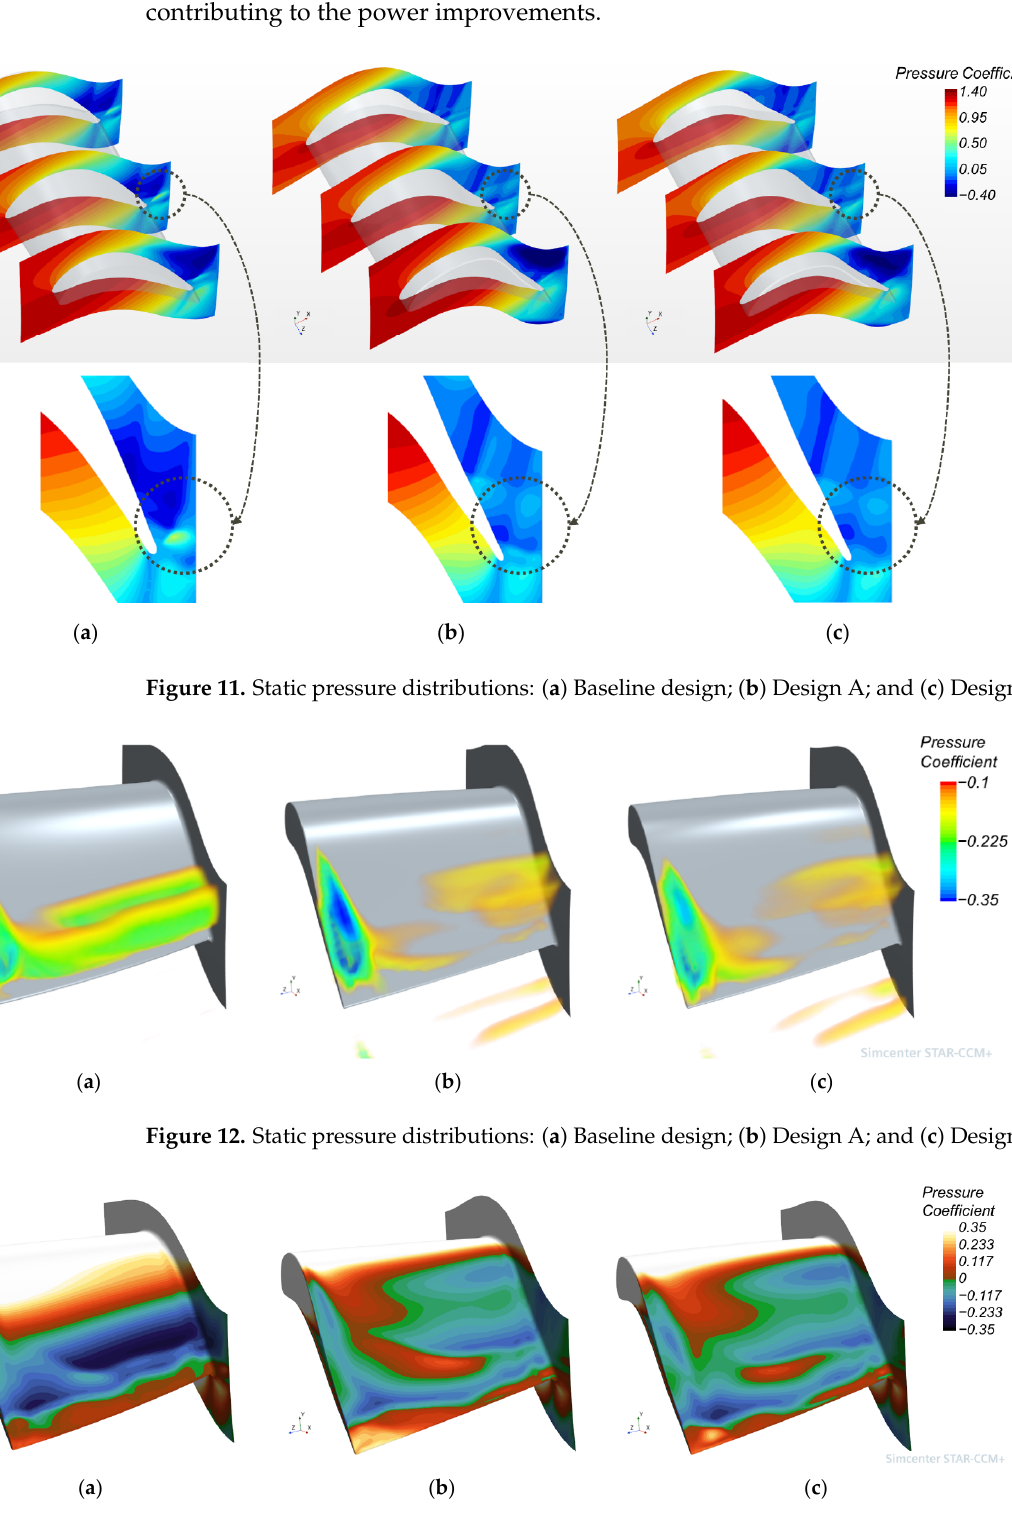
Figure 13. Pressure coefficient scenes on the surfaces of the blades: ( a ) Baseline design; ( b ) Design A; and ( c ) Design B. ated by focusing on visualizing changes in Mach number within the range between 0.8